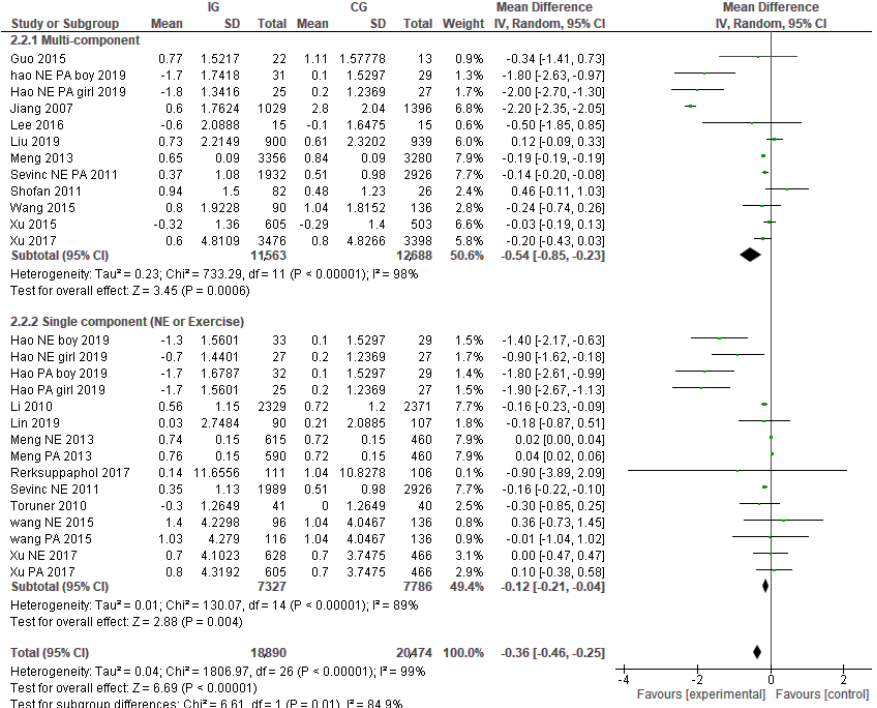
Figure 2. Overall effects on BMI and the difference between multi-component interventions and single-component interventions.